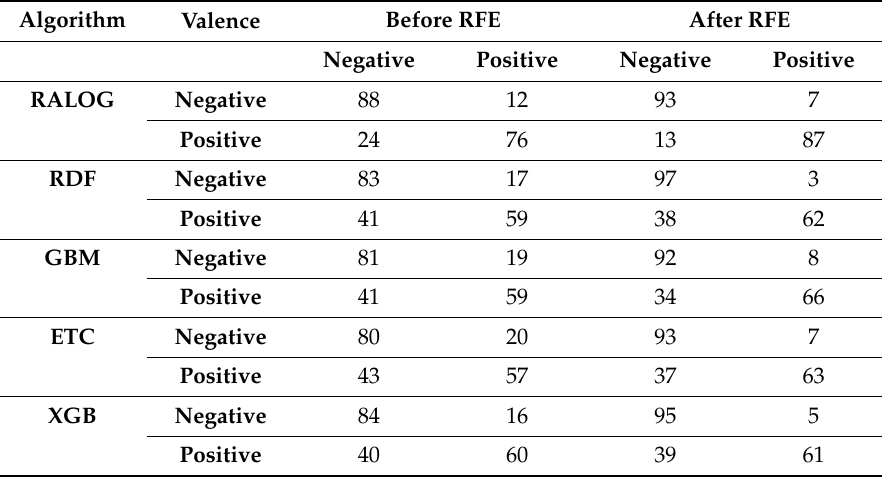
Table 8. Confusion matrix before and after feature scaling with the RF-RFE